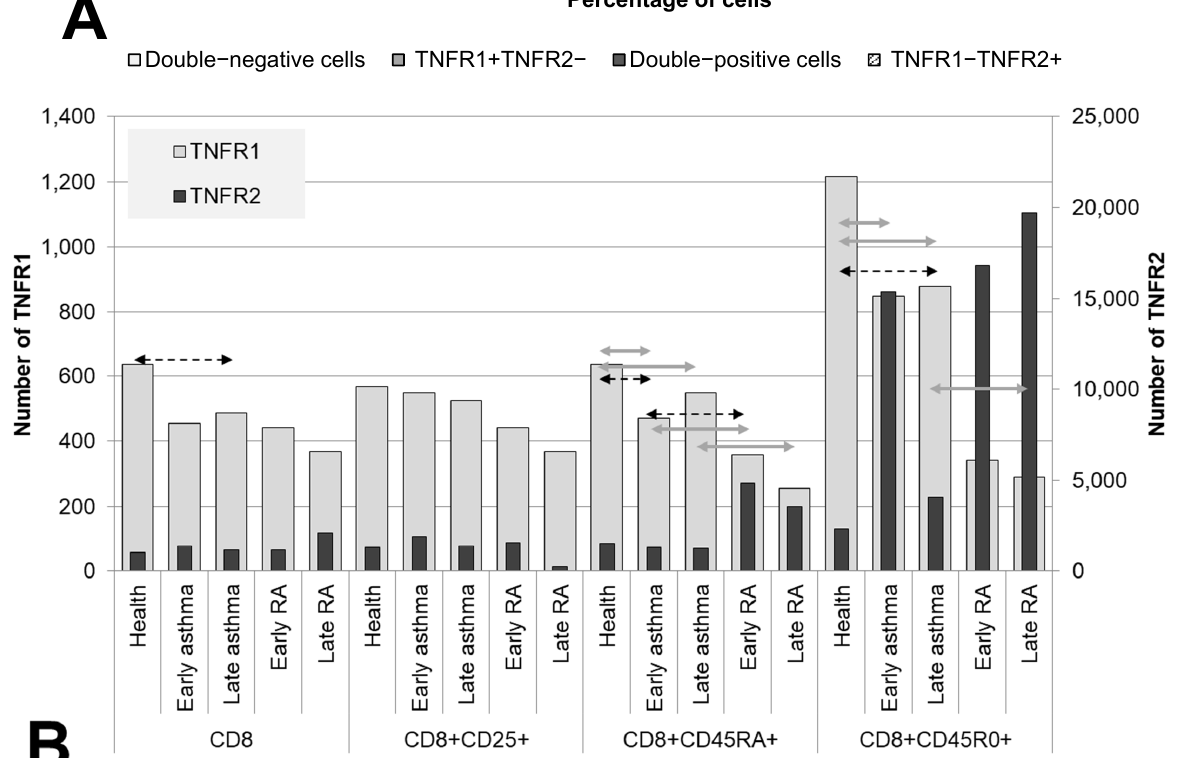
Figure 3. Co-expression ( A ) and density ( B ) of TNF receptors of types 1 and 2 in cytotoxic T lymphocytes subpopulations. Arrows indicate significant ( p < 0.05, Kruskal–Wallis test for multiple comparisons) differences in the expression level of TNFR1 between healthy individuals and RA or asthma patients and between patients at the same stage of the disease (between early RA and early asthma and between late RA and late asthma). Light grey arrows indicate differences for TNFR1; dark grey arrows indicate differences for